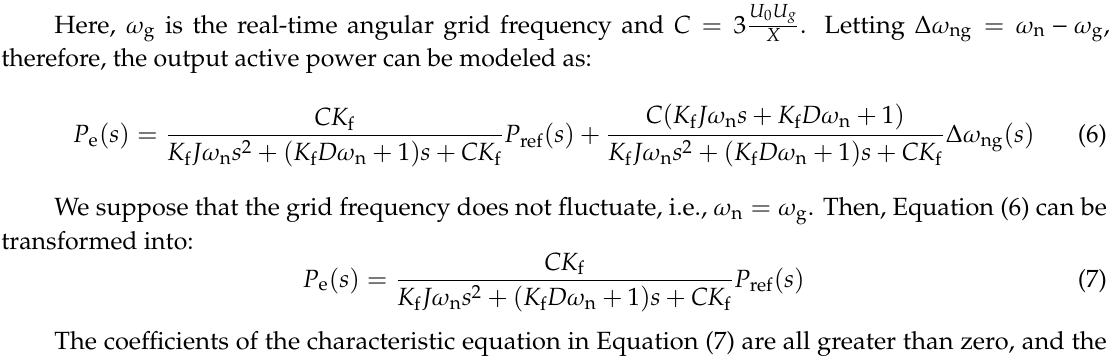
Figure 4. Power control diagram of grid-connected VSG.